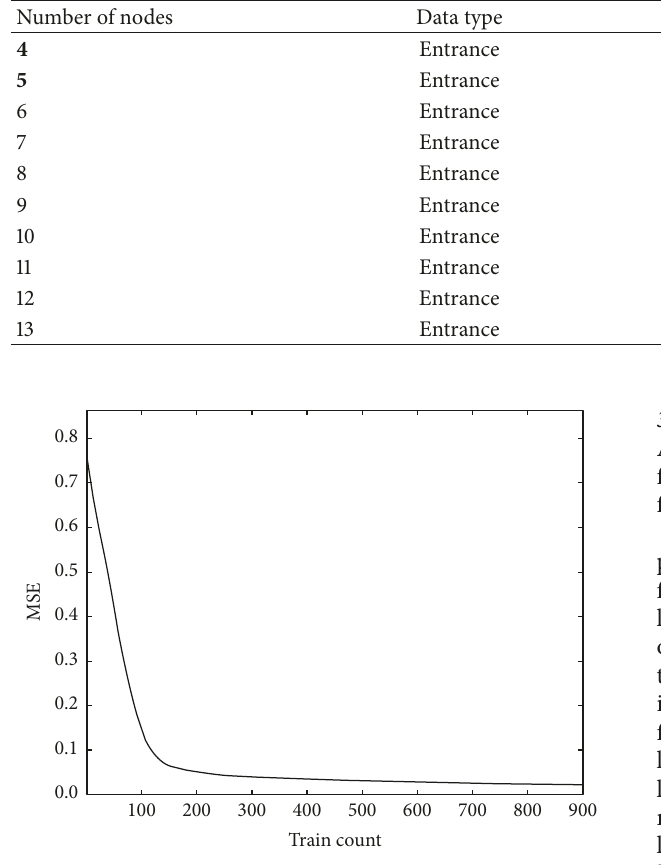
Figure 1: Diagram of relationship between training error and